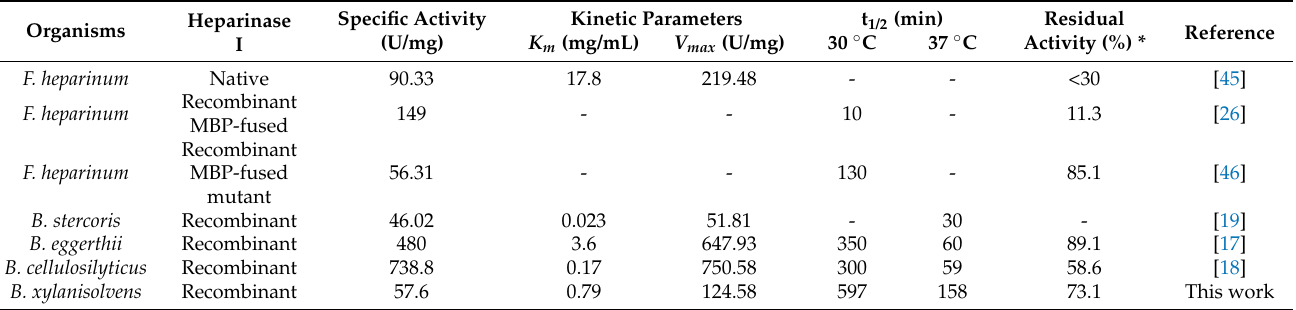
Table 1. Comparison of heparinases I from various